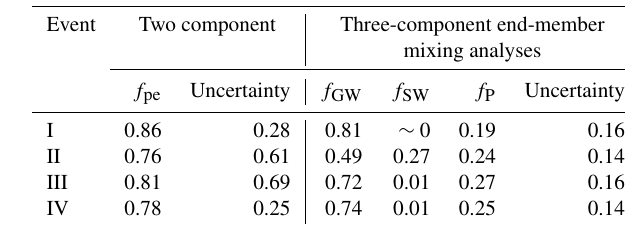
Table 4. Event-average pre-event water fraction ( f pe ) based on the two-component hydrograph separation using δ 2 H as a tracer, and the event-average fractions of groundwater ( f GW ), soil water ( f SW ) and rain water ( f P ) based on the three-component end-member mix- ing analyses and the associated uncertainties for both